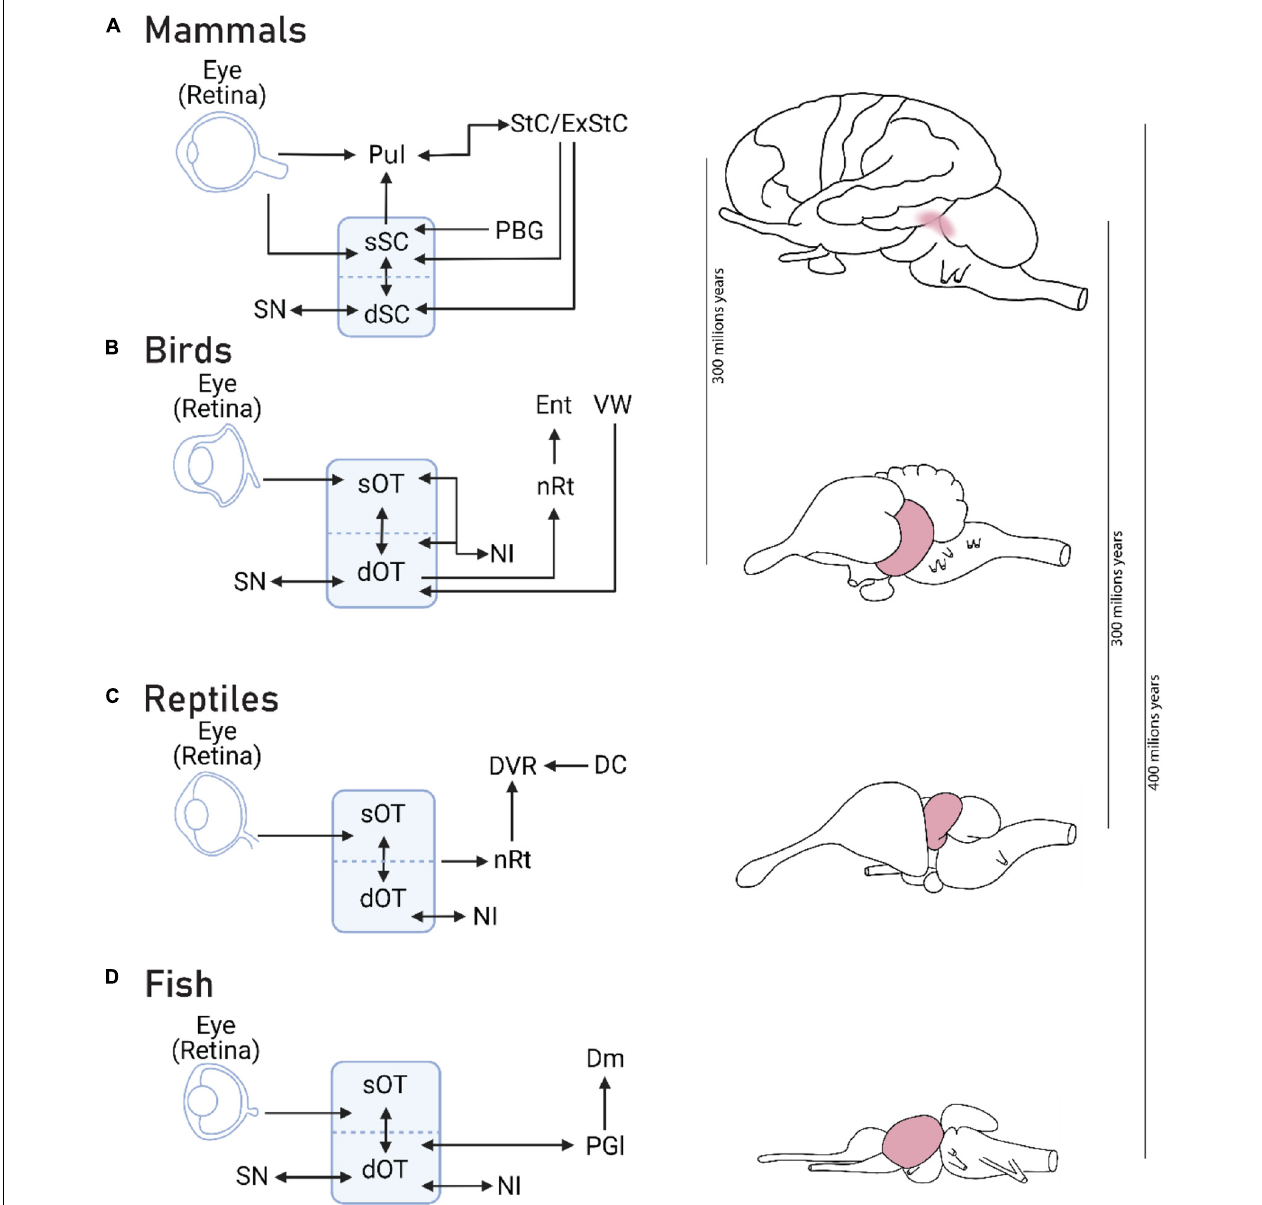
FIGURE 3 | The basic visual system of vertebrates integrates and selects information. The basic visual system of vertebrates is centered on the optic tectum (superior colliculus in mammals), shown on the right, in gray, on illustrations of: a mammalian (A) , avian (B) , reptilian (C), and fish (D) brain. Across taxa, the OT integrates bottom-up and top-down visual information for the control of orienting responses. Reciprocal interactions with nucleus isthmi (NI) or Parabigeminal nucleus (PBG; in mammals) is a joint feature of OT across vertebrates, which contributes to stimulus selection (Knudsen, 2018). Dm: Dorsomedial pallial amygdala; DVR: Dorsal ventricular ridge; Ent: Entopallium; ExStC: Extrastriate cortex; NI: Nucleus isthmi; nRt: Nucleus rotundus; PBG: Parabigeminal nucleus; PGI: Lateral preglomerular nucleus; Pul: Pulvinar nucleus; SN: Substancia nigra; sOT/dOT: Superficial/deep Optic tectum; sSC/dSC: Superficial/deep Superior colliculus; StC: Striate cortex; VW: Visual wulst. Diagrams based on: mammals – Mueller (2012) and Krauzlis et al. (2013), fish – Soares et al. (2017); reptiles – Naumann and Laurent (2020); birds – Mysore and Knudsen (2011).